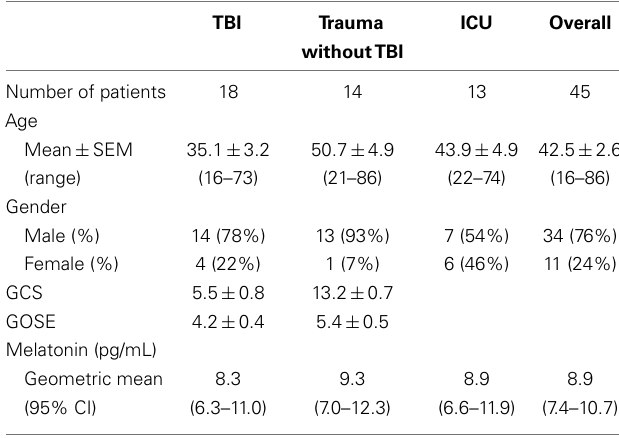
Table 1 | Epidemiological characteristics including age, gender, GCS, and GOSE where relevant, and mean/range of melatonin levels in three patient groups: severeTBI; trauma without severeTBI; medical conditions without trauma orTBI (demographics)